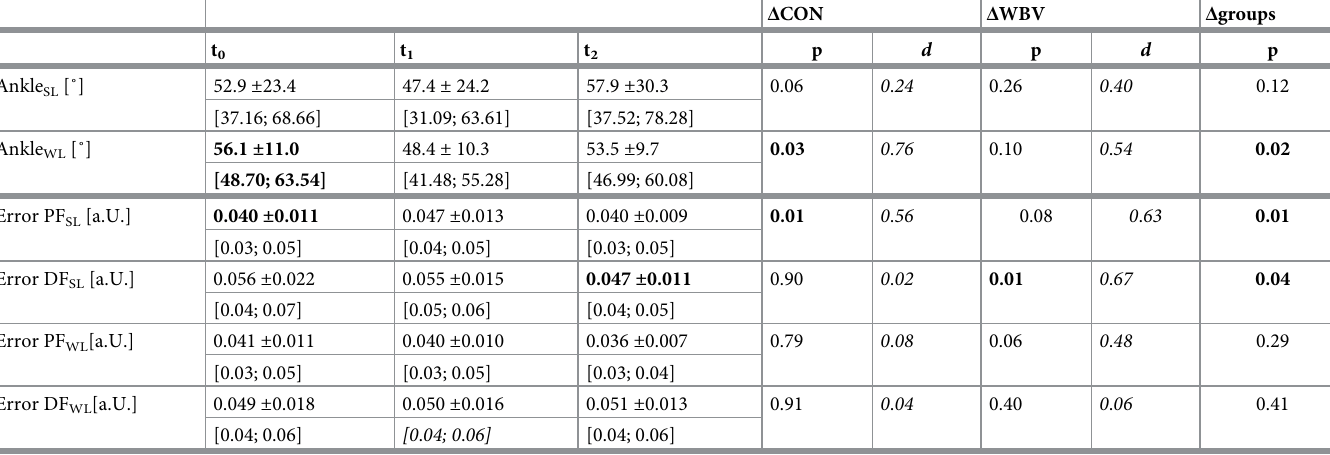
Table 2. Results of angular mobility and motor accuracy for the active range of motion (top) and motor precision task (bottom) of the ankle joint.